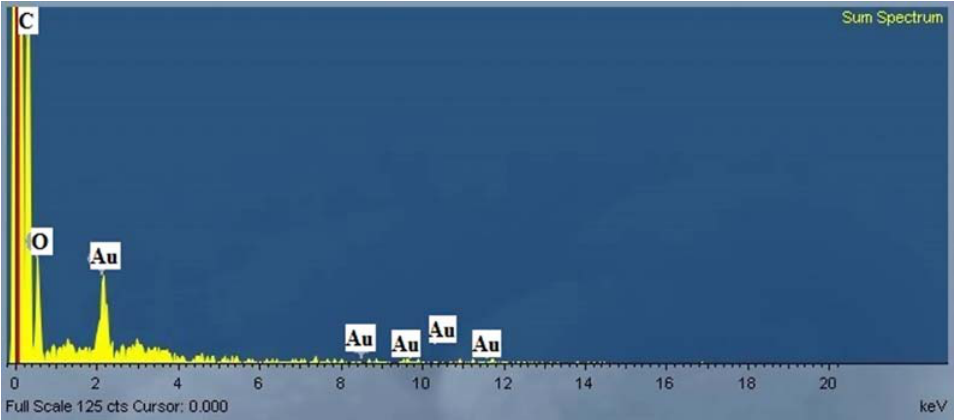
Figure 6. EDX graph of g3.